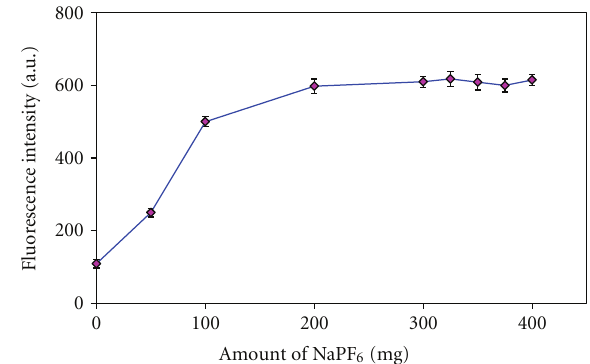
Figure 2: Influence of amount of [Hpy][PF 6 ] on the fluores- cence intensities. Experimental conditions: terazosin concentration 75 μ g L − 1 ; pH 10; NaPF 6 350 mg.